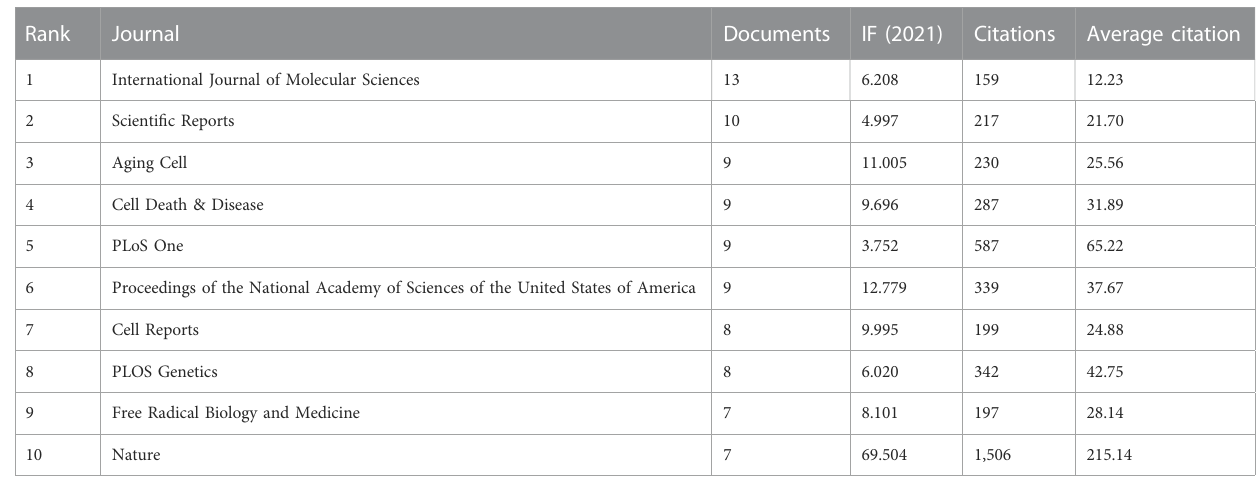
TABLE 1 The top 10 journals related to UPR mt . Rank